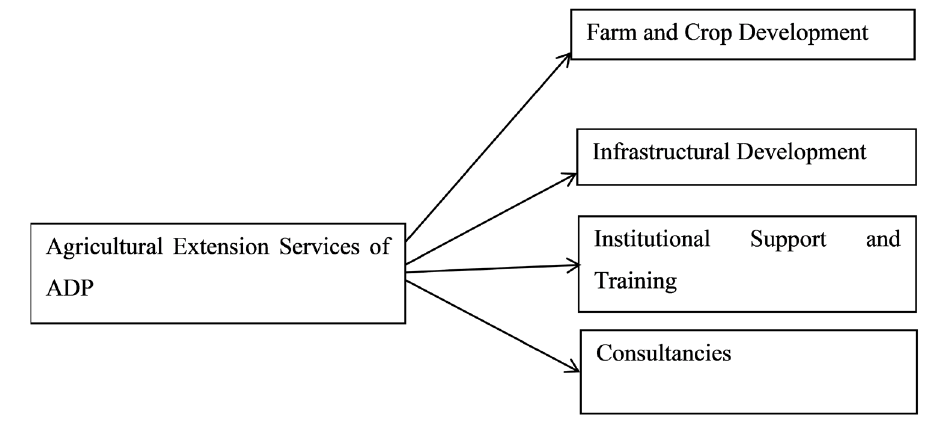
Figure 1. Conceptual model (Authors’ proposition,